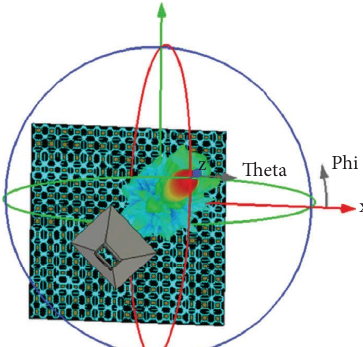
Figure 14: Simulation of a 3D radiation